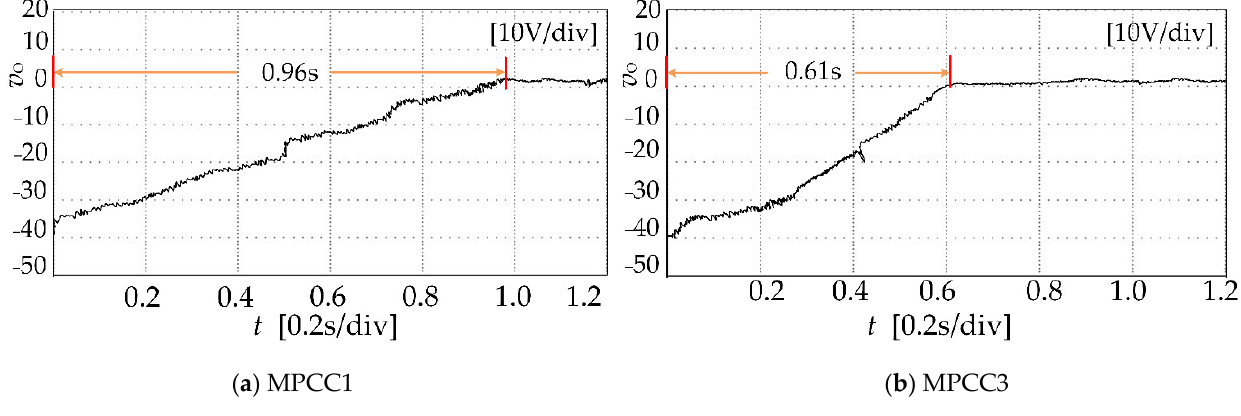
Figure 8. Neutral point potential balance capability.